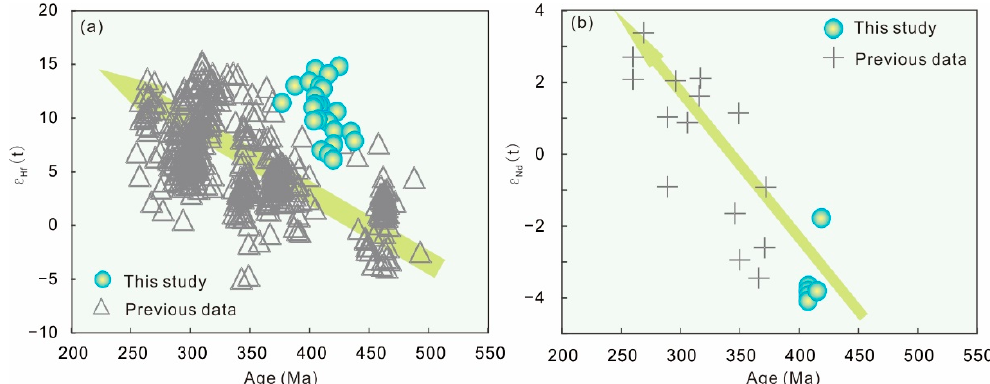
Figure 10. ( a ) In situ zircon ε Hf (t) values versus U-Pb ages and ( b ) whole rock ε Nd (t) values versus U-Pb ages diagrams for the Paleozoic magmatic rocks in the northern margin of Yili Block (previous data are collected from [9] and its references).